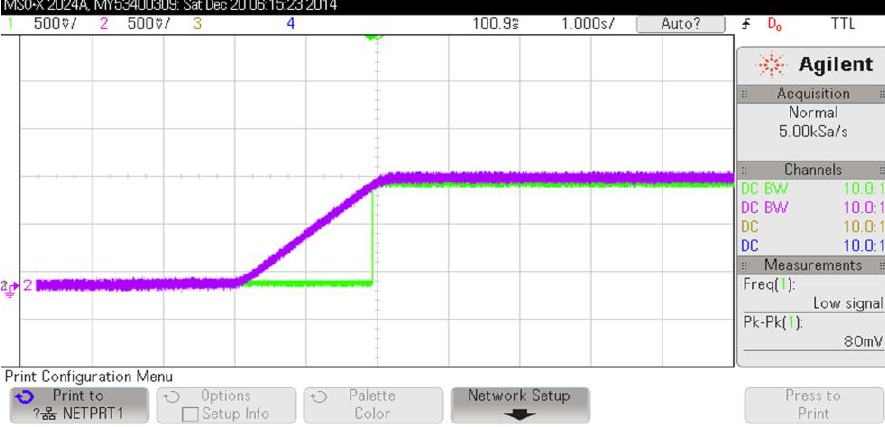
Figure 13. Measured storage capacitor voltage (V out ) and V START